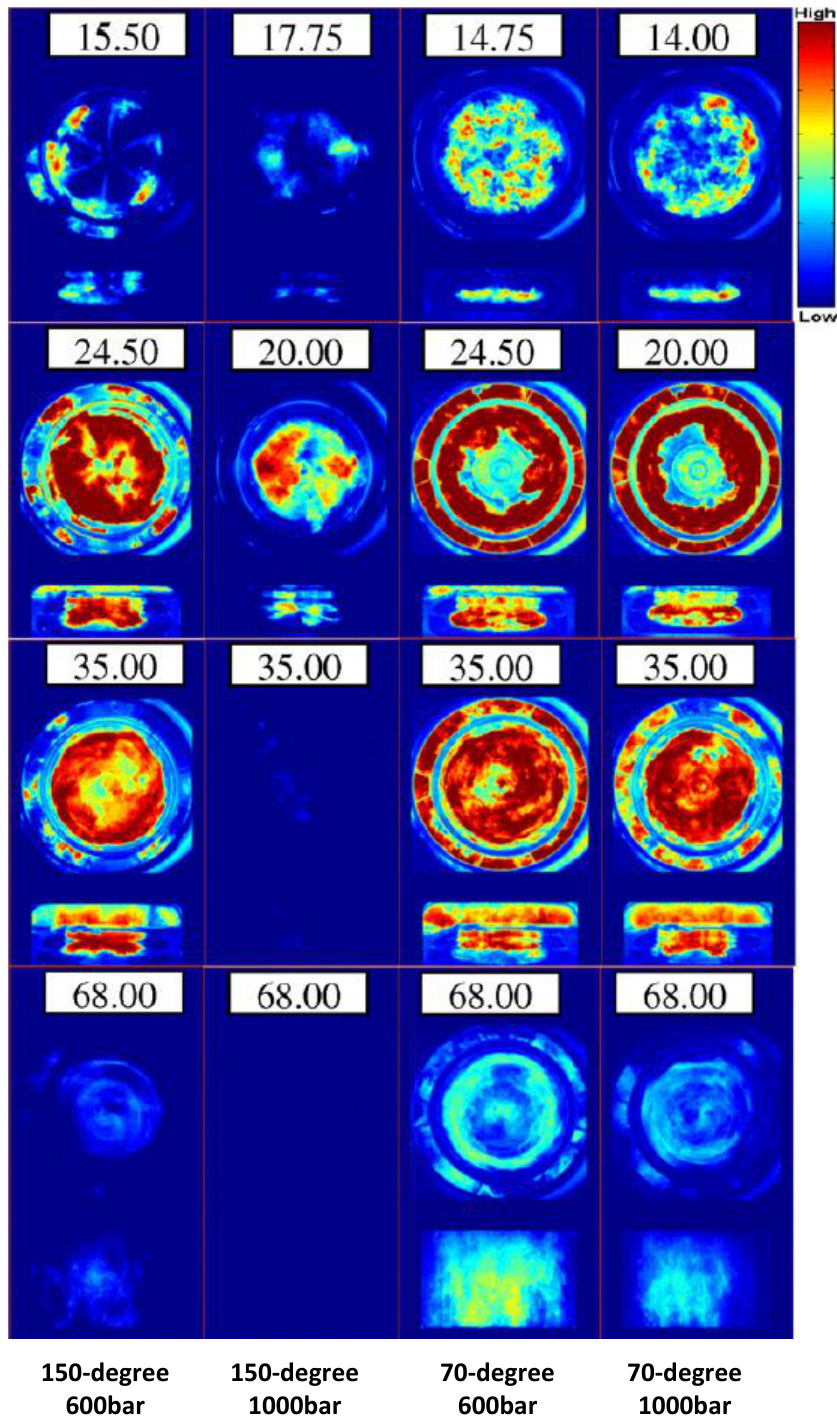
Figure 12. Combustion images of injection angles and injection pressures at different crank angles [52].